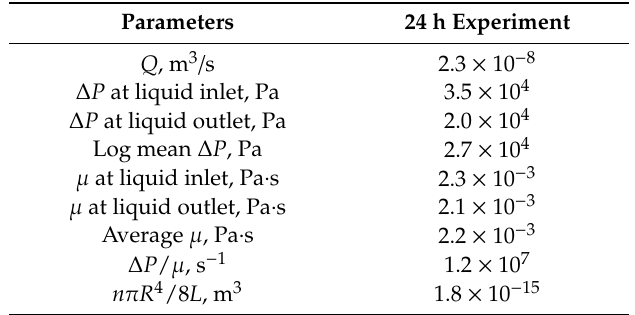
Table 3. Calculation parameters for the degree of membrane wetting ( n π R 4 /8 L ).